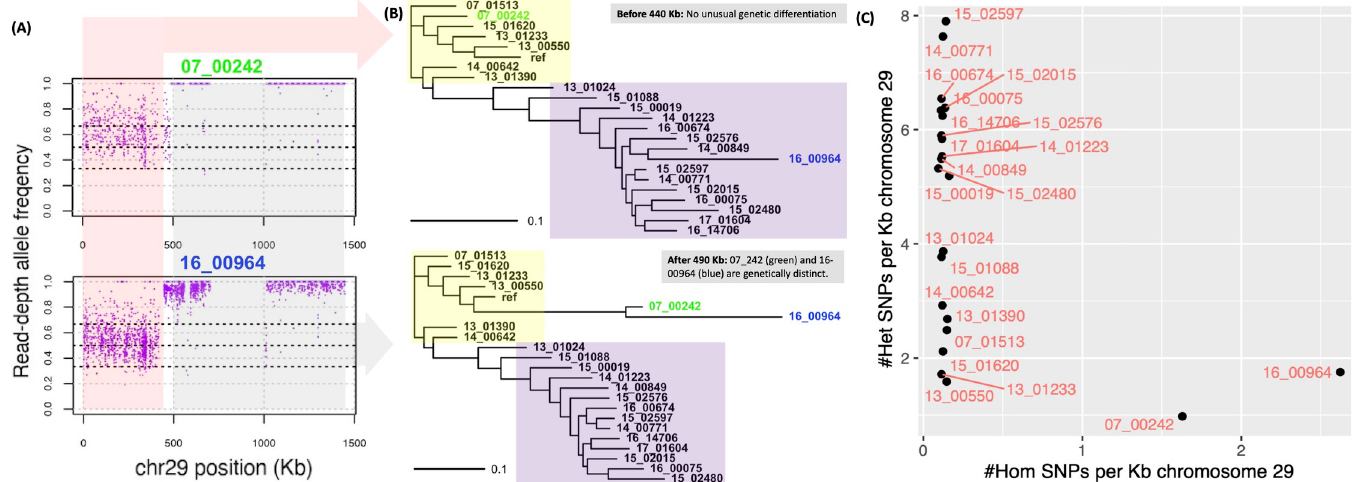
Fig 5. RDAF distributions (A) and phylogenies (B) constructed from SNPs at chromosome 29 from 0–440 Kb (pink RDAF, top phylogeny) and > 490 Kb (grey RDAF, bottom phylogeny) showing the genetic relatedness of the 22 isolates with the L . tropica reference genome (“ref”). This showed unique segments of genetically distinct ancestries in 07_00242 (green) and 16_00964 (blue)—both came from patients originally from Iran. All samples were disomic for chromosome 29. The inferred genetically distinct groups are represented by the L . tropica reference (yellow area) and non-reference groups (purple area). (C) The homozygous (x-axis) and heterozygous (y-axis) SNPs per Kb for all 22